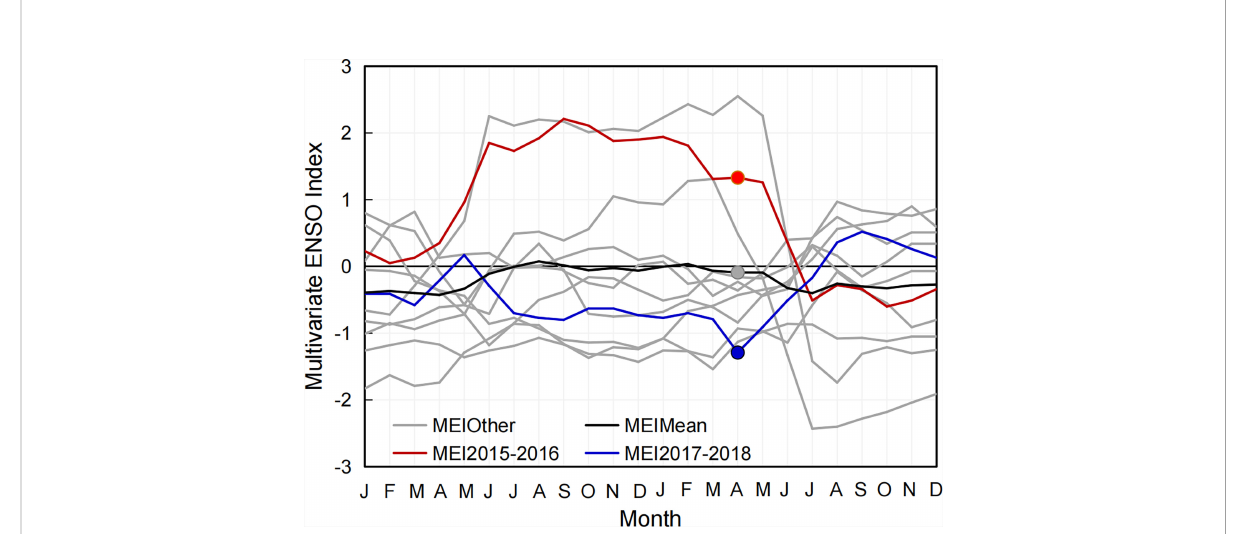
FIGURE 2 Two-year progression of the bi-monthly multivariate El Niño/Southern Oscillation (ENSO) index since